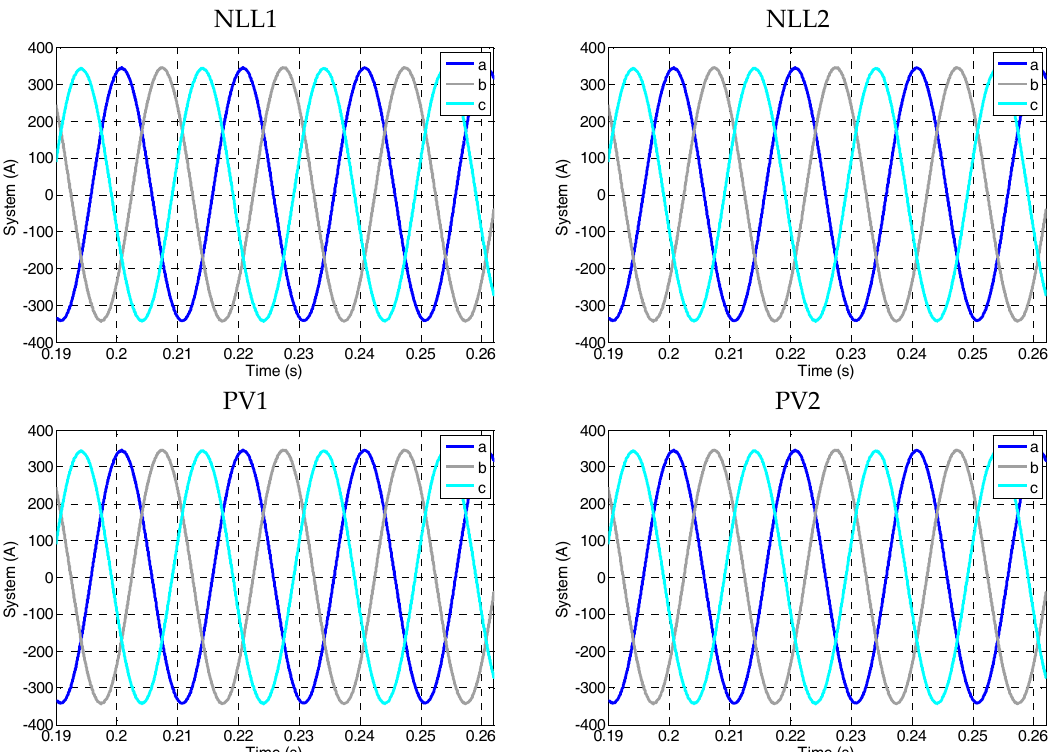
Figure 8. Output current waveforms of DGs and nonlinear loads (NLLs) after proposed control method.